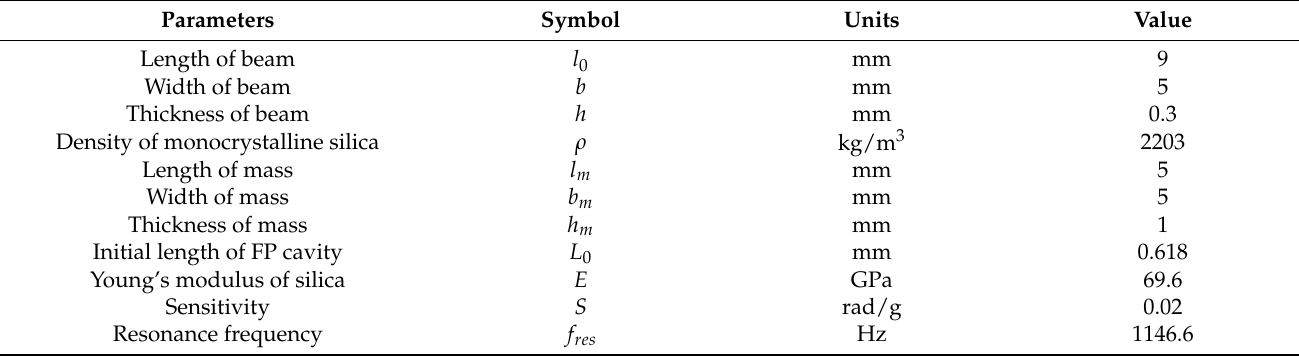
Table 1. Parameters of the